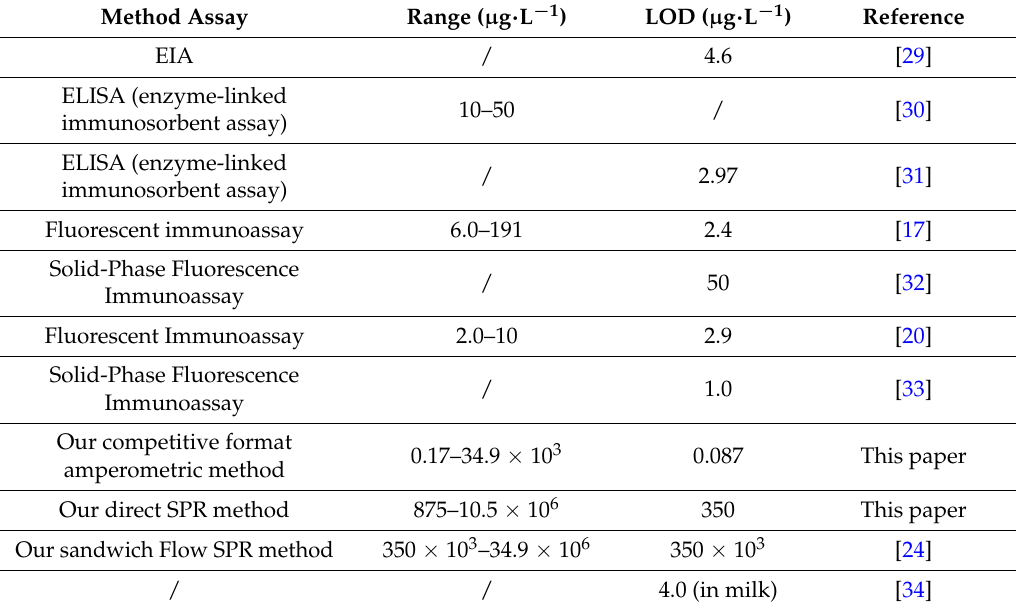
Table 7. Data found using other immunoassay methods and immunosensor methods that we have